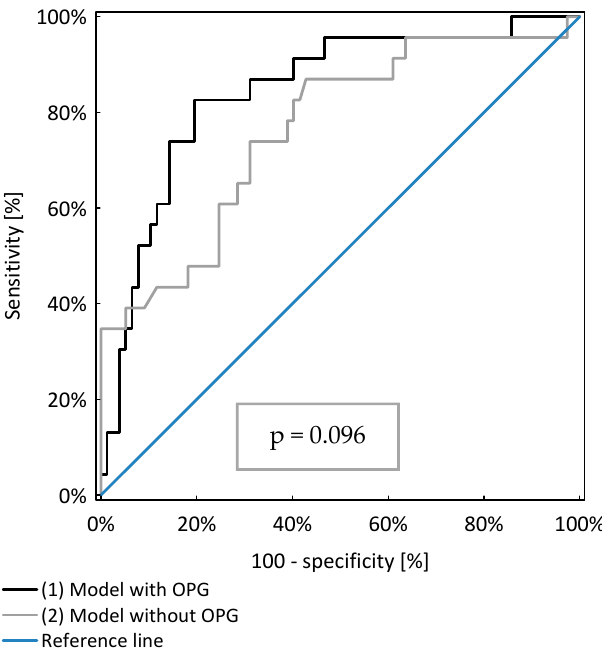
Figure 1. Comparison of two models of logistic regression analysis identifying CKD patients with anaemia.